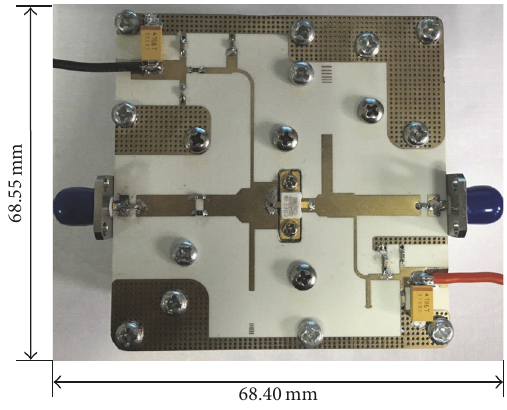
The drain efficiency and PAE are between 52%–76%